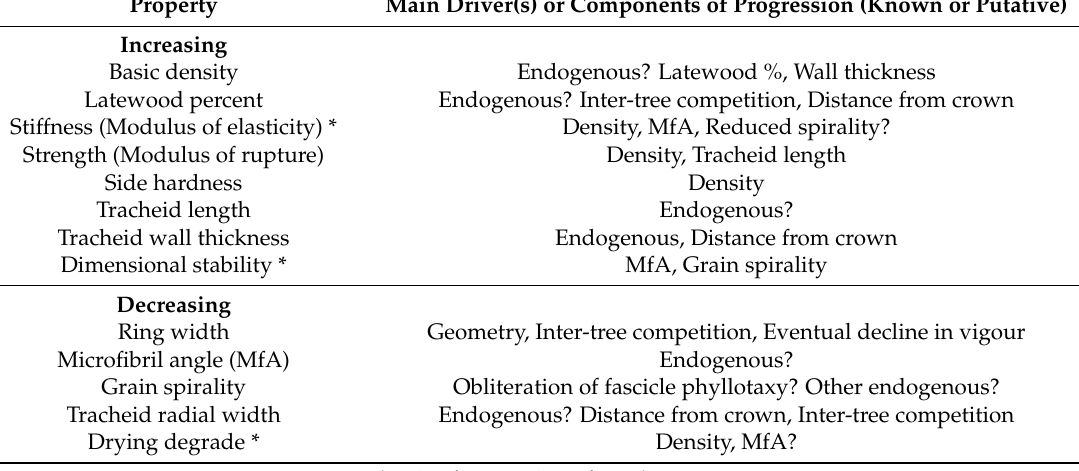
Table 2. Behaviour of some individual wood properties in the corewood-outerwood progression in radiata pine, with inferred drivers or